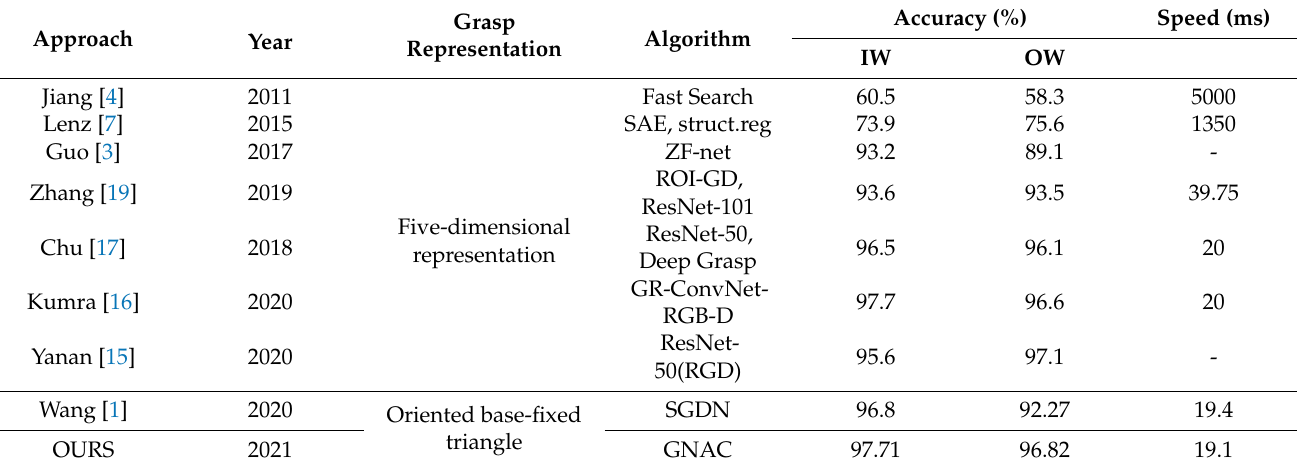
Table 2. Test results on the Cornell Grasp